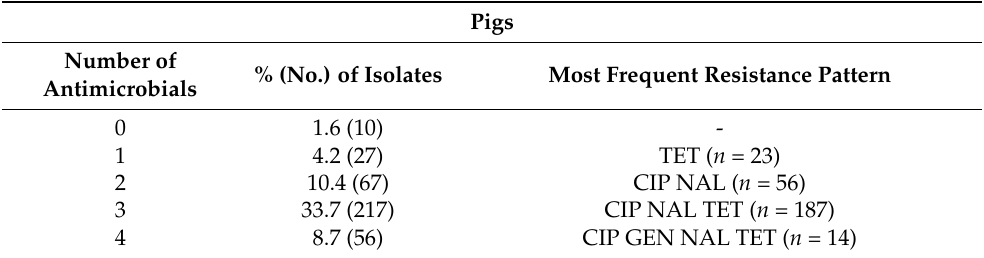
Table 2. Frequent resistance patterns in C. coli isolated from pigs ( n = 643) and chickens ( n = 575) from 2010 to 2018 in